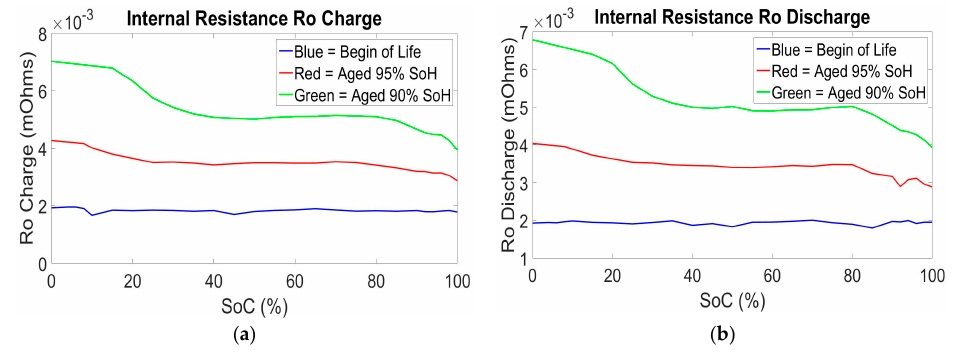
Figure 4. OCV difference between a fresh begin of life (BoL) and aged (90% SoH) lithium ion cell: ( a ) OCV charge; and ( b ) OCV discharge.